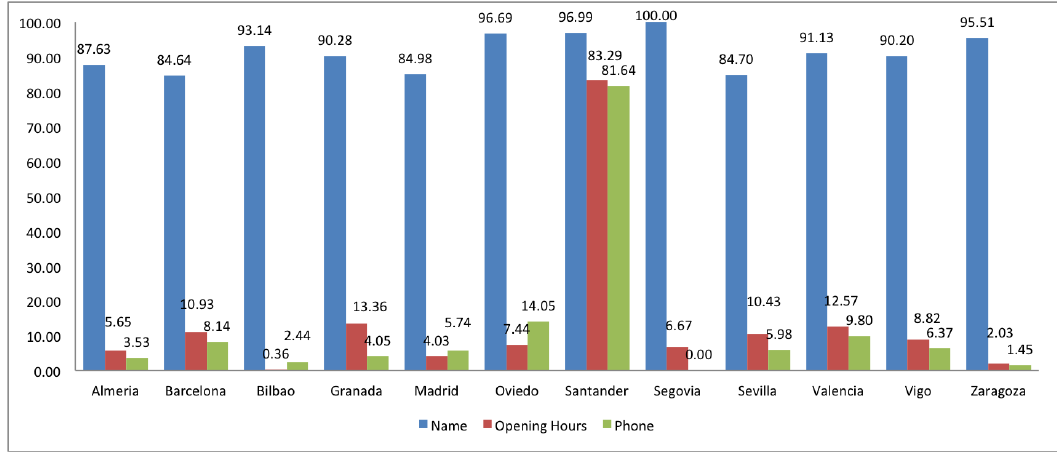
Figure 4. Completeness study in Spain. Percentage of name, opening hours and phone in amenities.